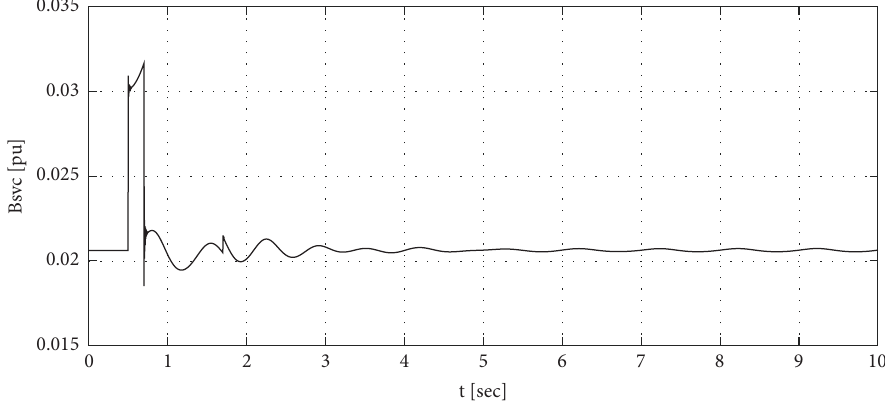
Figure 9: Te current generator with MMLOC and SMC.